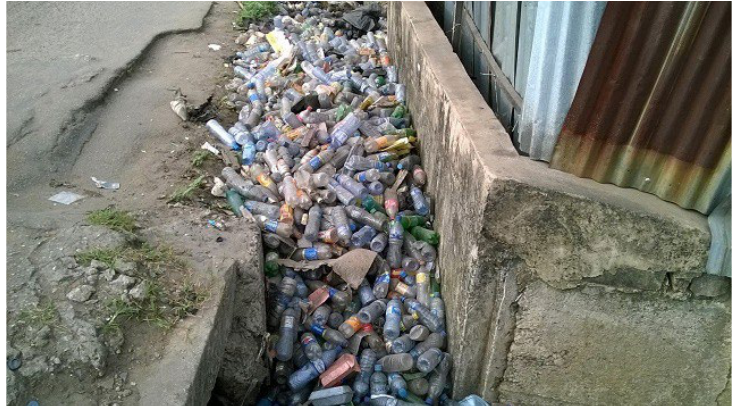
Figure 1. Plastic waste blocking a drainage system in Lagos, Nigeria